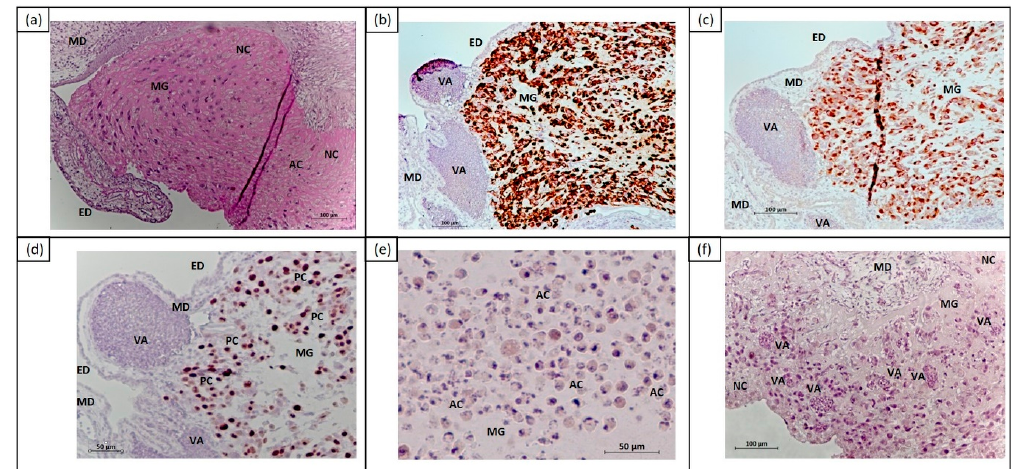
Figure 3. FFPE sections of CAM including human 92.1 UM cells for analysis of cytotoxic effects of